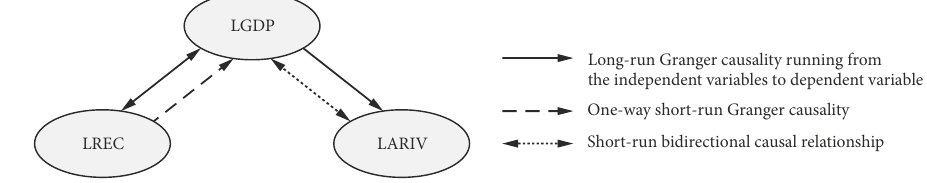
Long-run Granger causality running from the independent variables to dependent variable One-way short-run Granger causality Short-run bidirectional